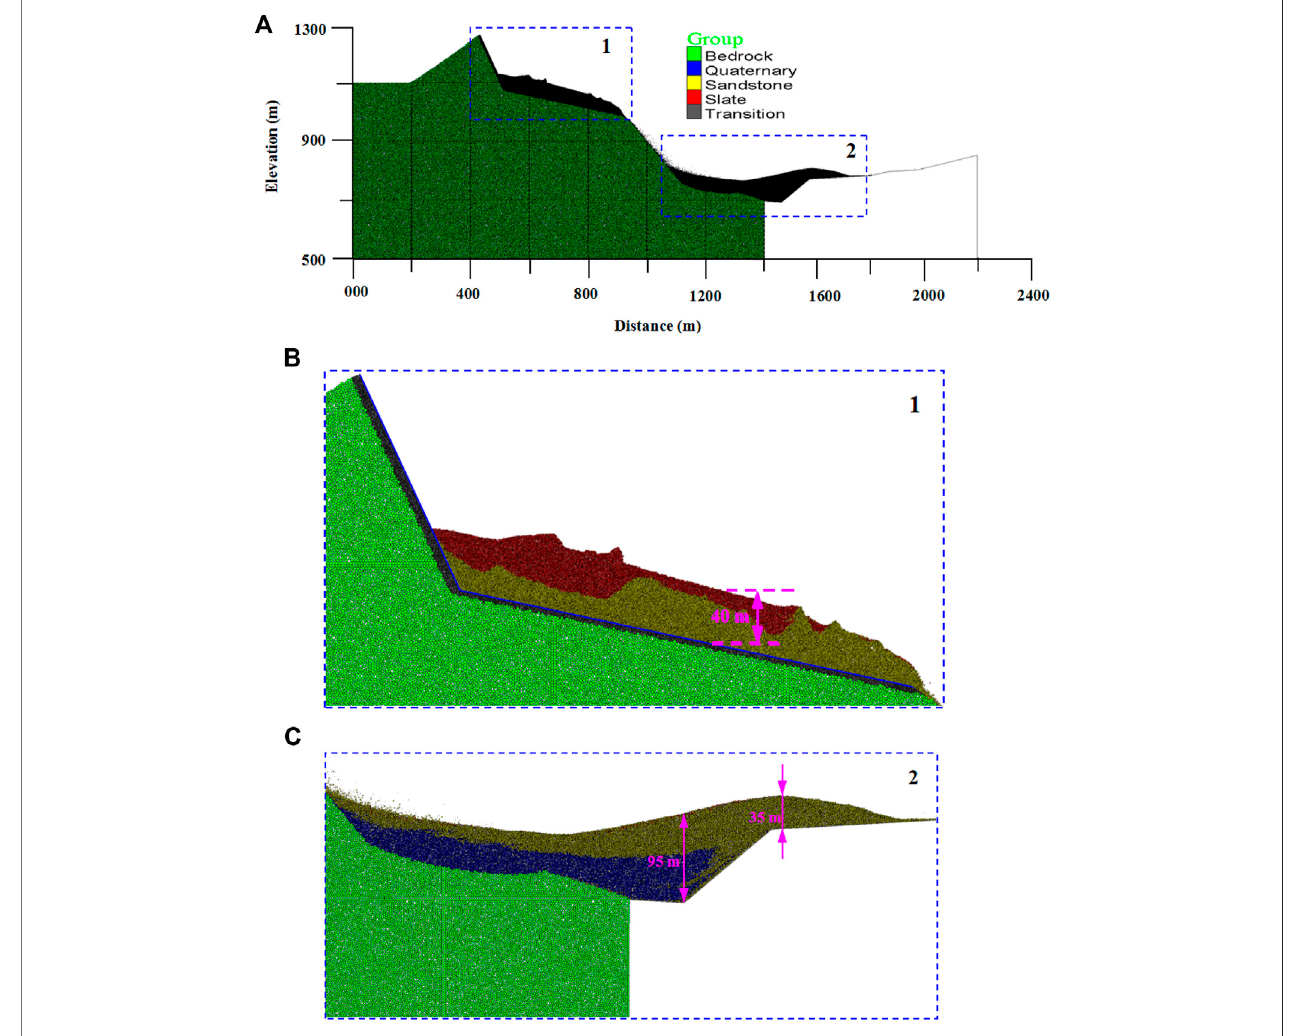
FIGURE 12 | Ultimate landslide deposit accumulation. (A) Entire model. (B) Deposits in the upper source area. (C) Deposits in the valley of the Duba River.